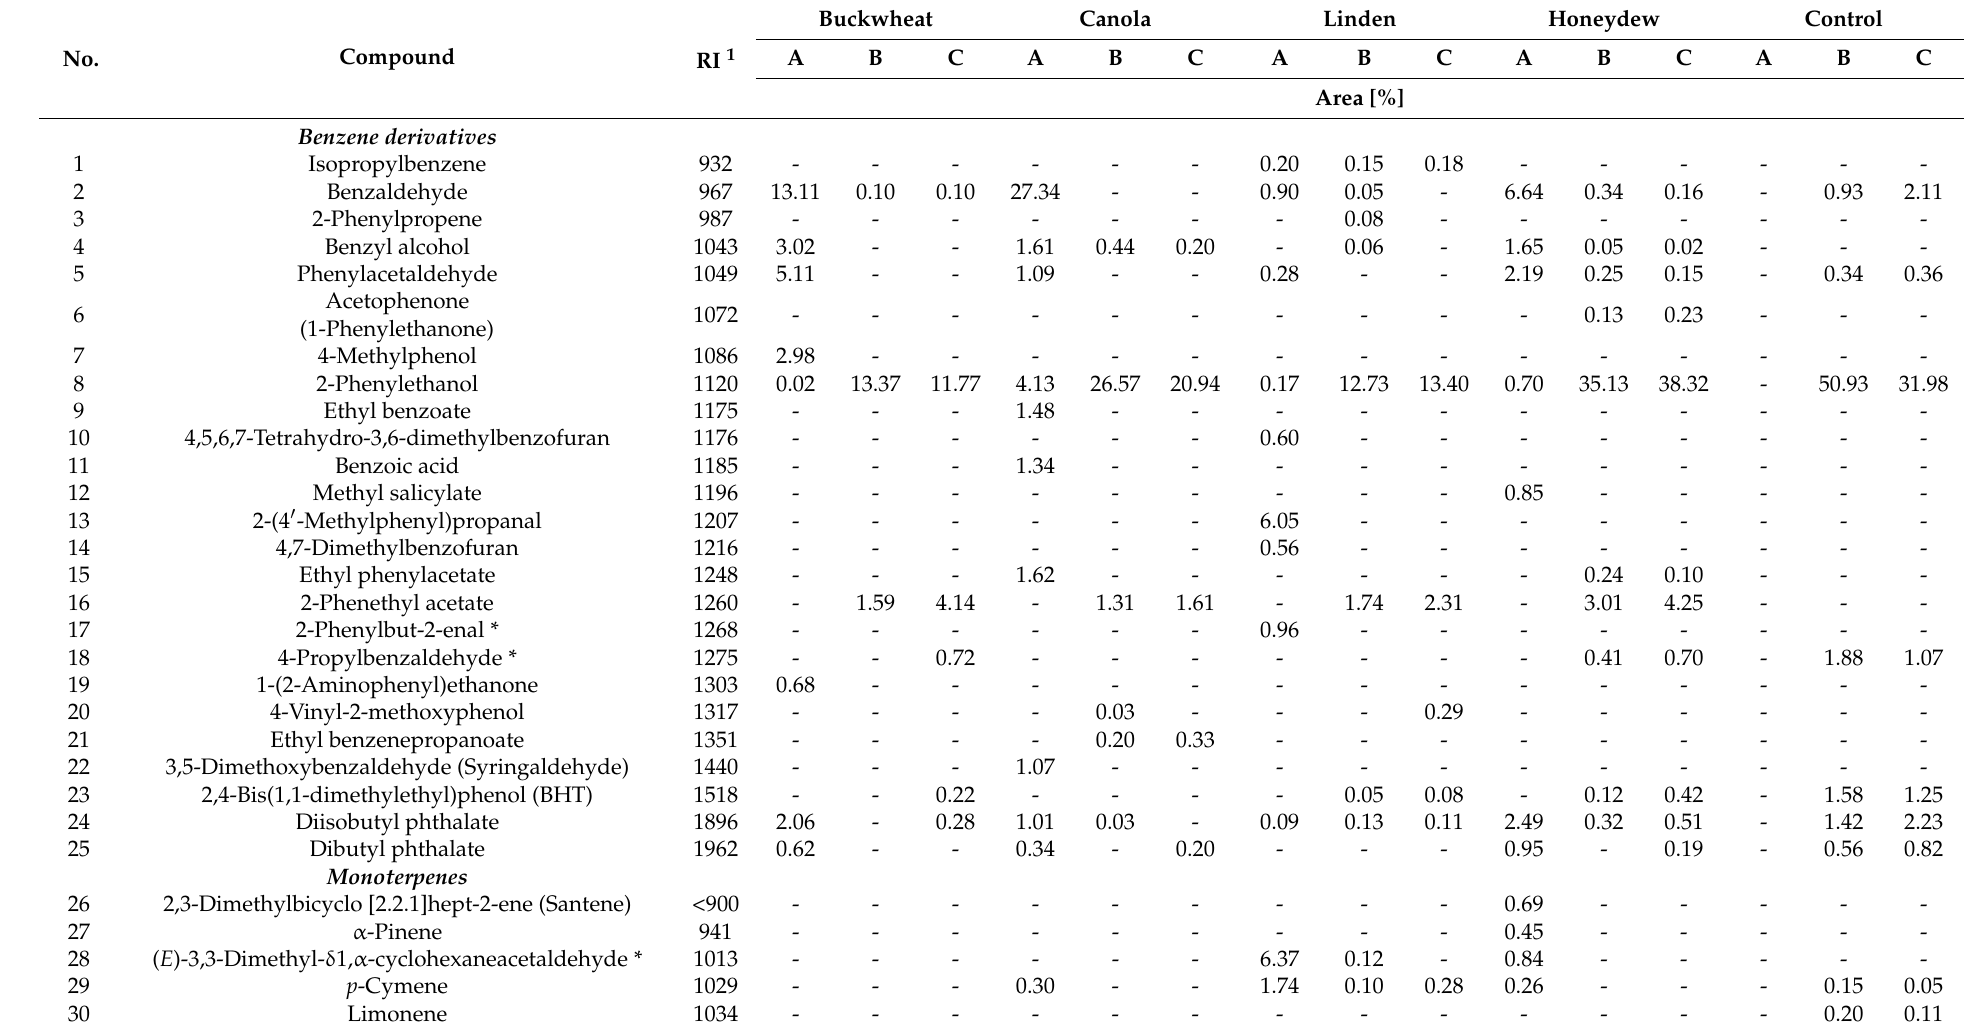
Table 1. Comparison of the HS-SPME profiles of meads and related unifloral